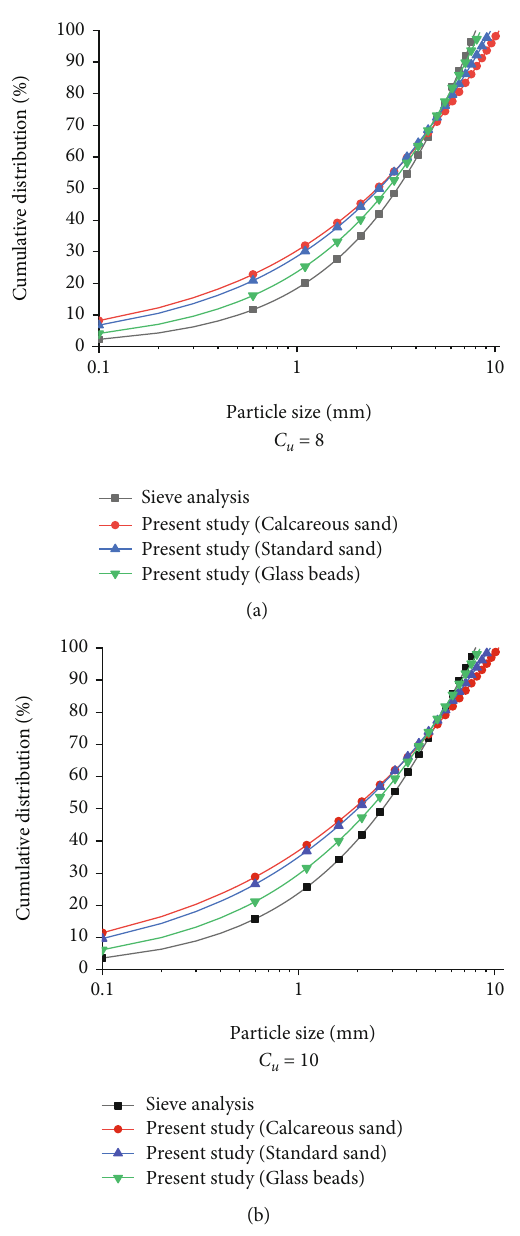
Figure 12: Calculation of a case of the speci fi c